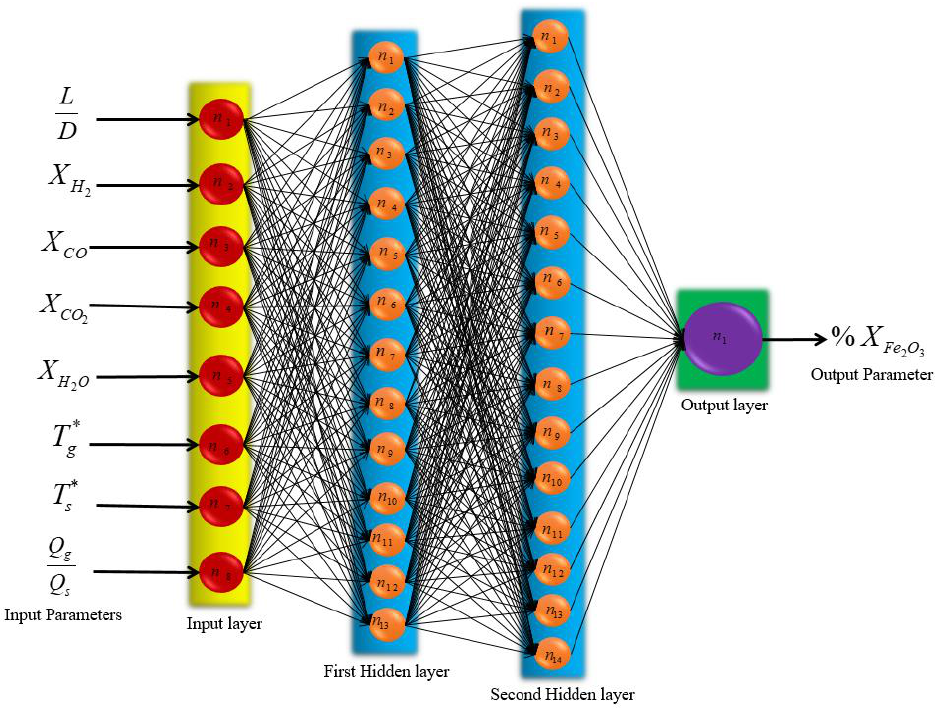
Figure 13. Schematic of final MLP